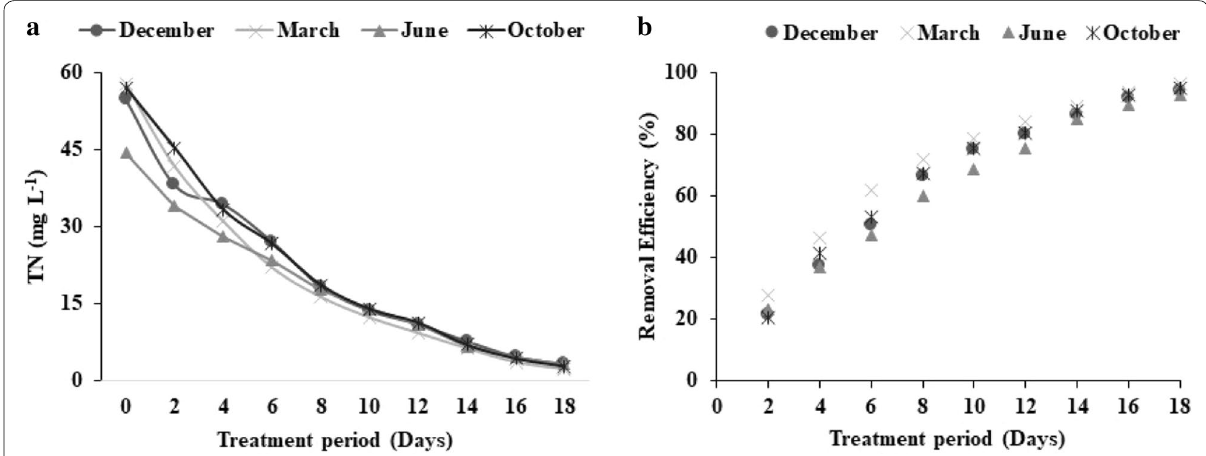
Fig. 3 Change of concentration ( a ) removal efficiencies ( b ) of TN over the experimental periods of each